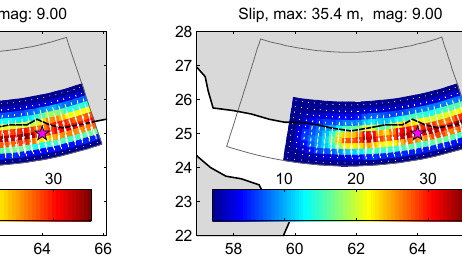
Figure C3. Examples for the randomization of the slip distribution (and rake